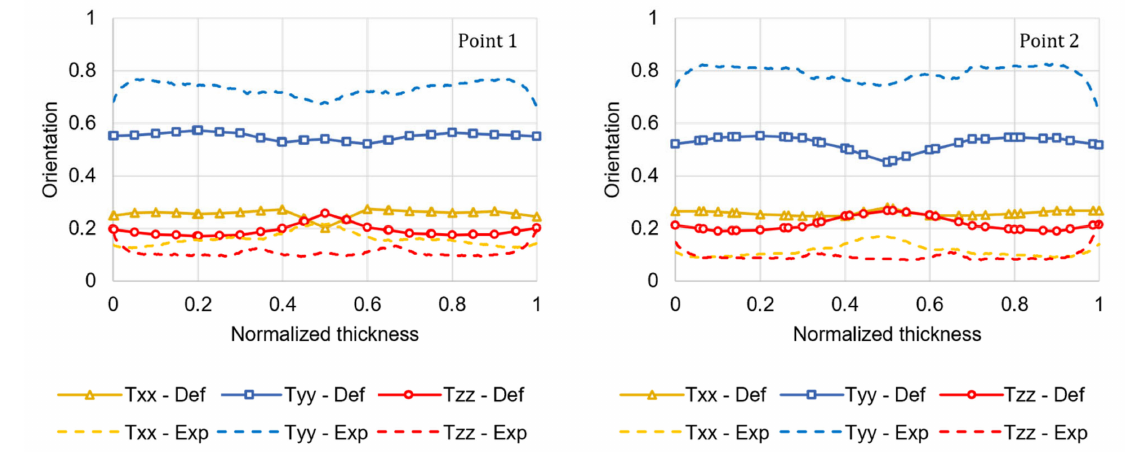
Figure 10. Comparison between the µ CT experimental results (Exp) of the fiber orientation tensor principal components and the numerical results (Def) predicted using the default coefficients of the RSC model for the two ROIs in the tensile specimen.